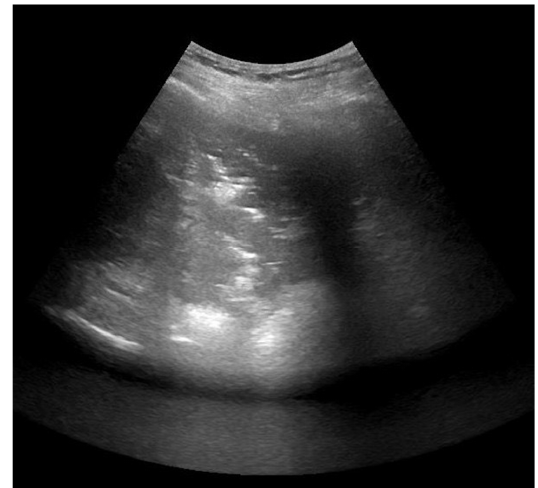
Figure A4. Consolidation—score 3.